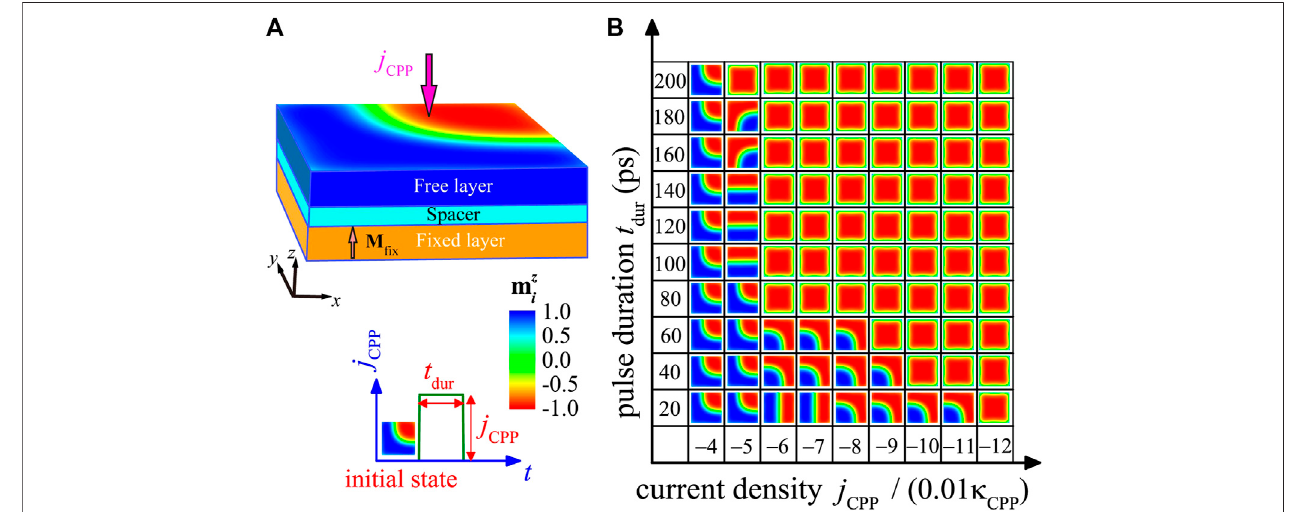
FIGURE 6 | (A) Sketch of a MTJ nanopillar consisting of the top and bottom layers of ferromagnet, and the spacer layer of insulator. (B) Simulations for the evolutions of kink driven by a CPP pulse, starting from an initial kink with p (cid:2) − 1 in UR corner of the nanostructure. A phase diagram for the equilibrated states obtained after the current pulses, as a function of current density j CPP and duration time t dur